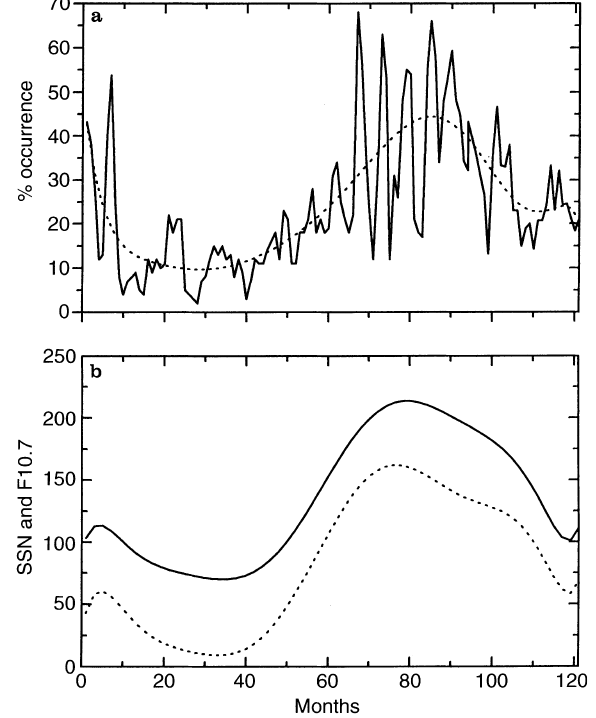
Fig. 2a, b. Variation of monthly mean a percentage occurrence of night-time scintillations and b Rz ( dashed curve ) and F 10.7 ( solid line ) for the period 1983–1993